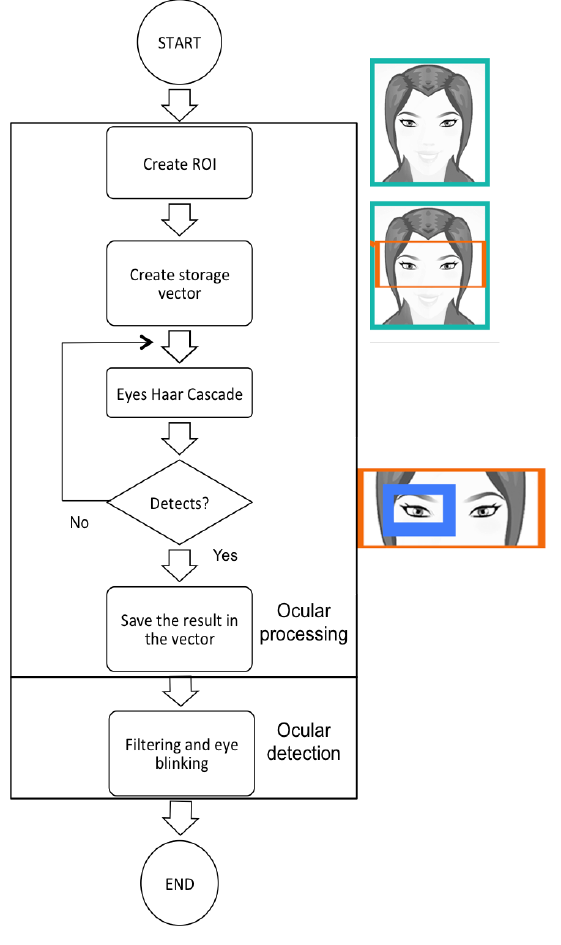
Figure 8. Low-level diagram of third